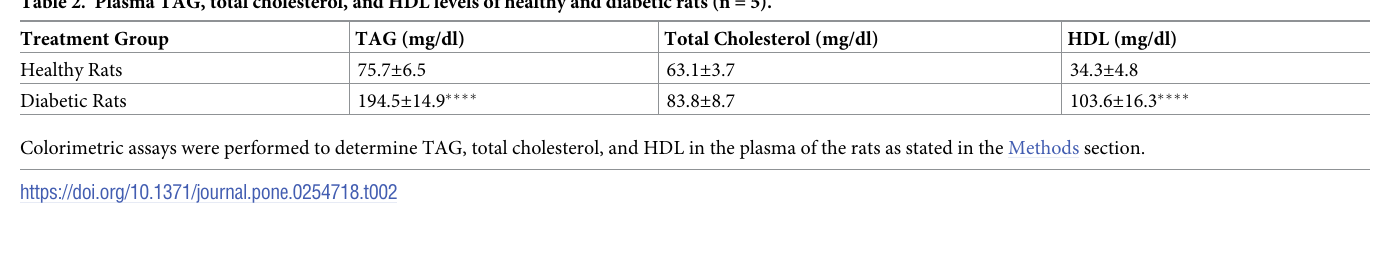
Table 2. Plasma TAG, total cholesterol, and HDL levels of healthy and diabetic rats (n = 5).